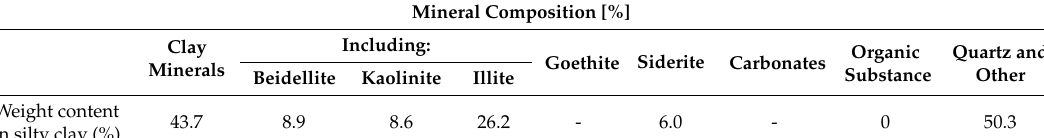
Table 1. Mineral and chemical composition of silty clay used in examined soil mixtures [5].